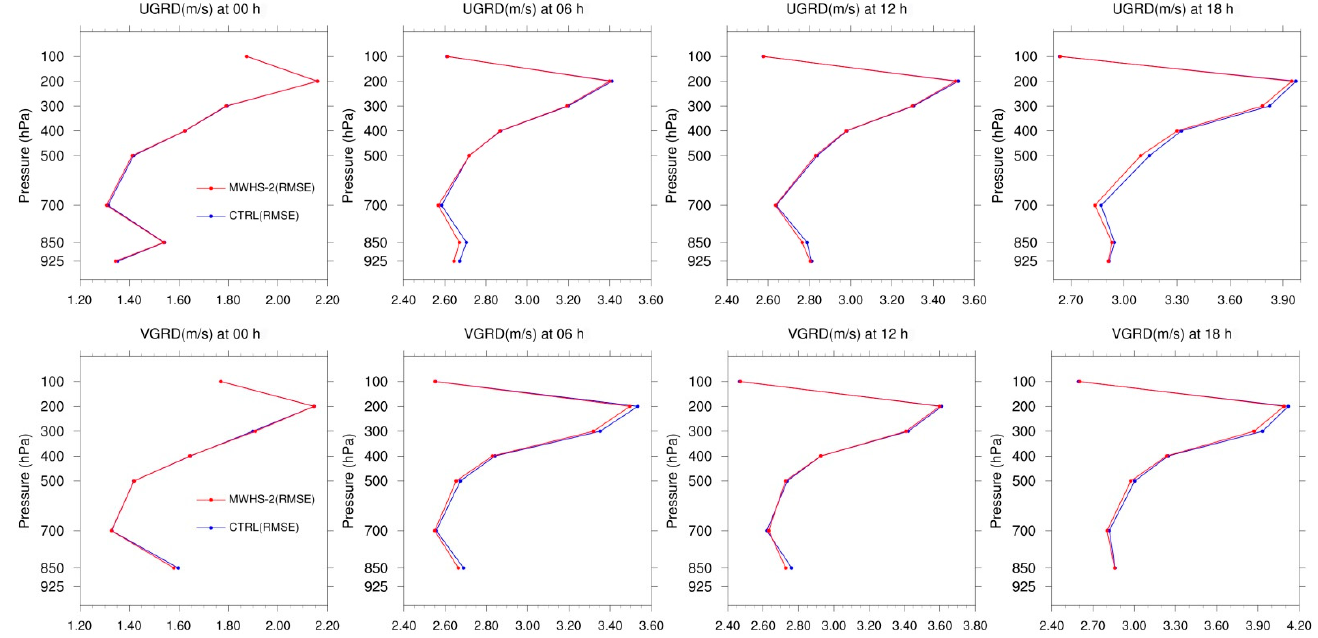
Figure 8. RMSEs of the forecasting zonal (UGRD: first row) wind and meridional (VGRD: second row) wind for CTRL (blue line) and MWHS-2 (red line) experiments against observations at 00 h, 06 h, 12 h, and 18 h of the forecasts.